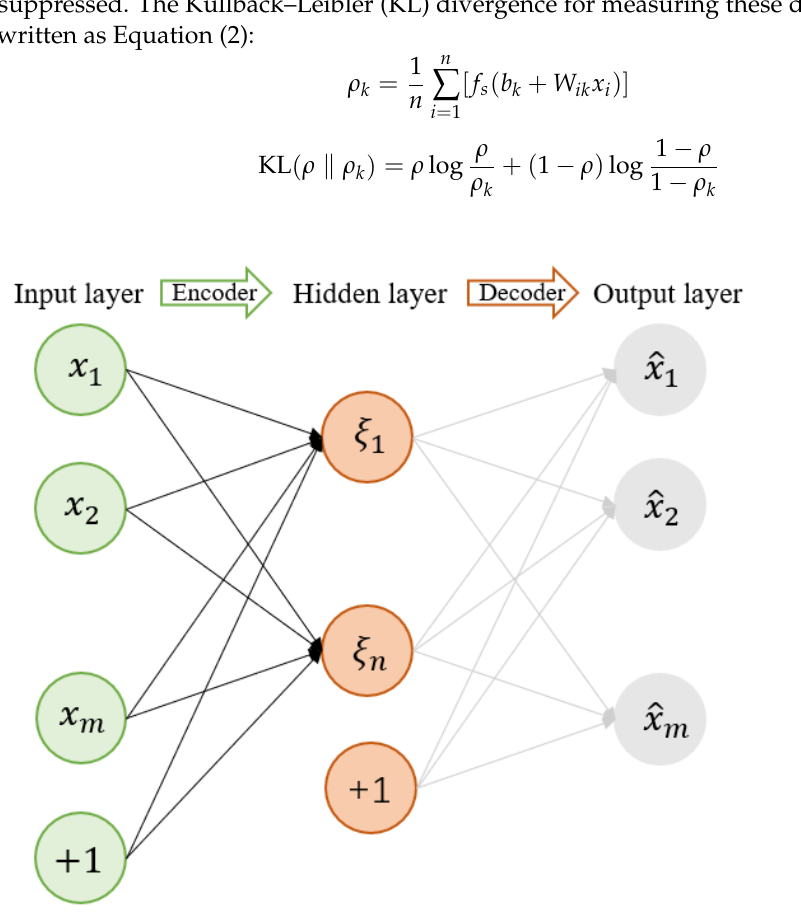
Figure 2. The schematic of the auto encoder.